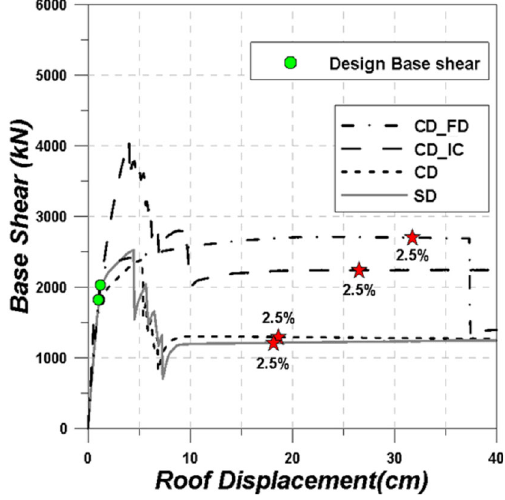
Fig. 25 Pushover curves of the model structures designed using R =